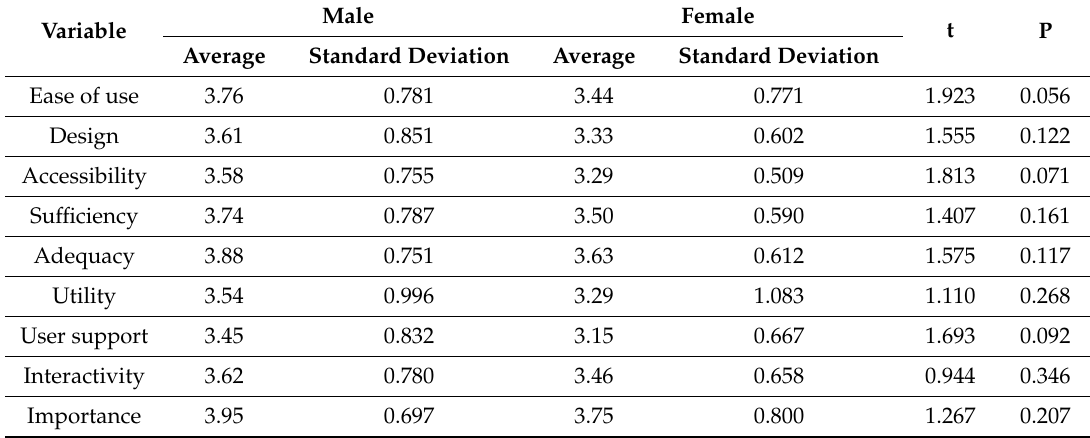
Table 6. Comparison of satisfaction by gender